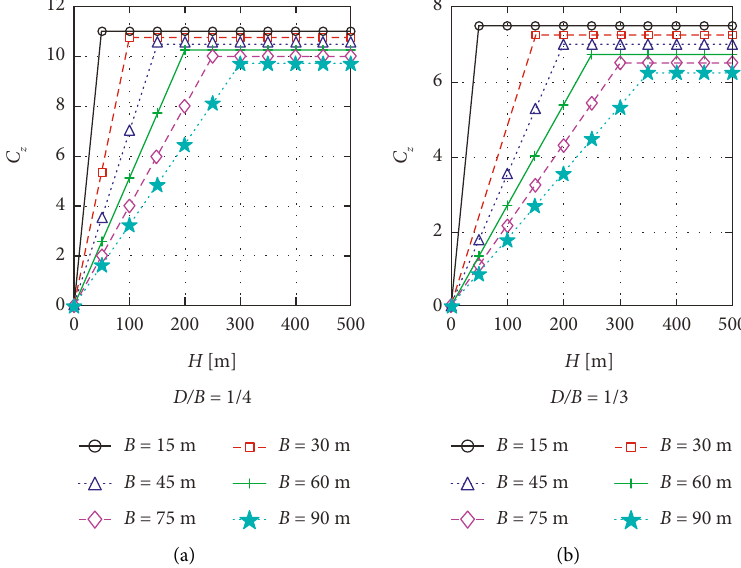
Figure 13: Proposed vertical decay constants for wind-induced torque on rectangular tall buildings: D/B � 1/4 and D/B � 1/3.